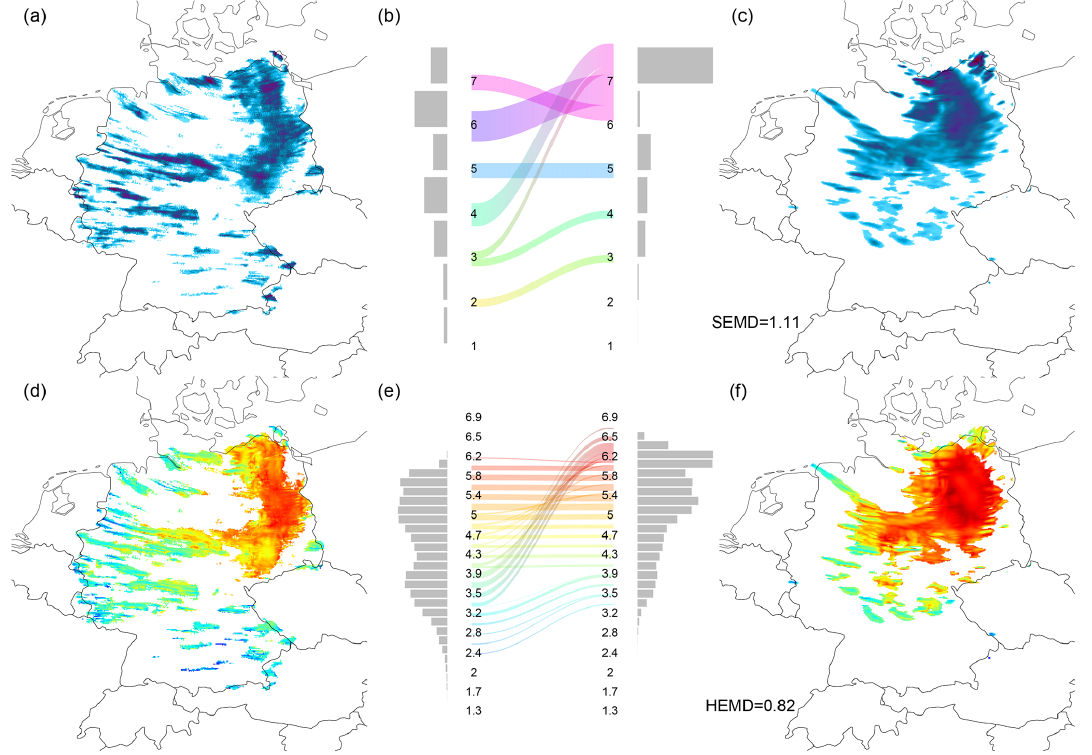
Figure 7. Wavelet-based verification for 19 June 2011 at 16:00UTC: observed field (RADOLAN, a ); observed spectrum, EMD components and forecast spectrum (b) ; forecast field (Member 5, c ). Bottom row: observed map of central scales (d) ; corresponding histogram, EMD components, forecast scale histogram (e) ; forecast map of scales (f) .